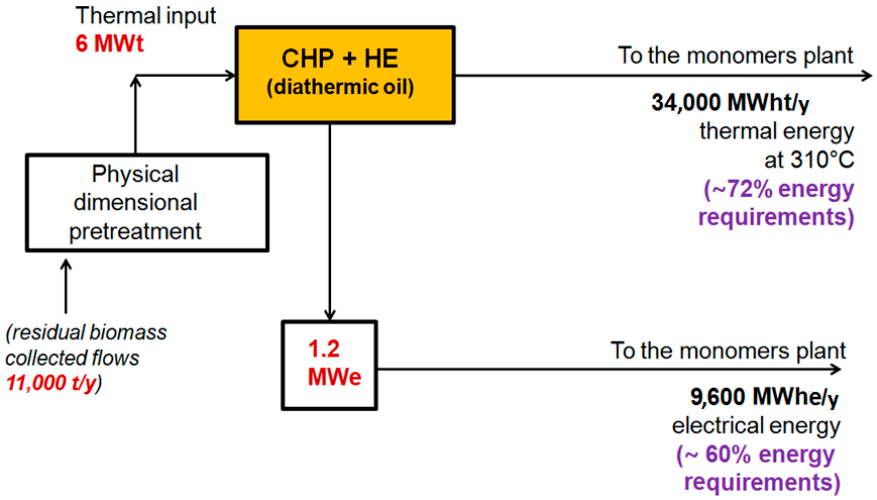
Figure 2. SCENARIO 1 ‐ Energy recovery from the residual biomass ( cardoon and carthamus ).